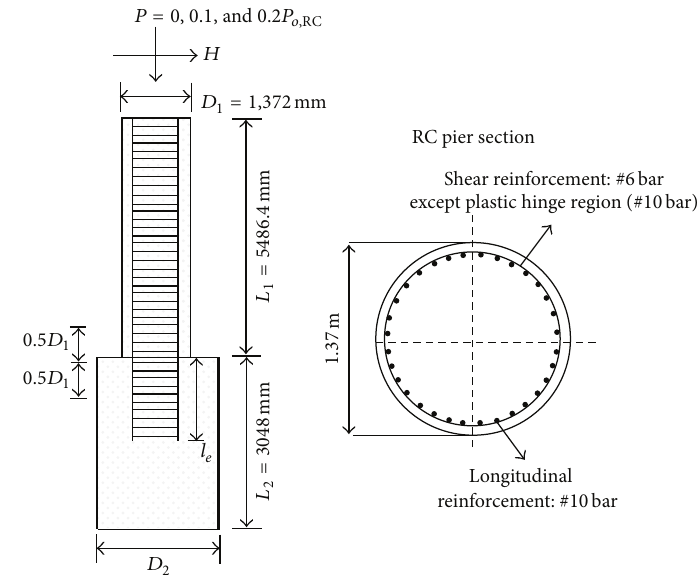
Figure 7: Analytical model for parametric study.